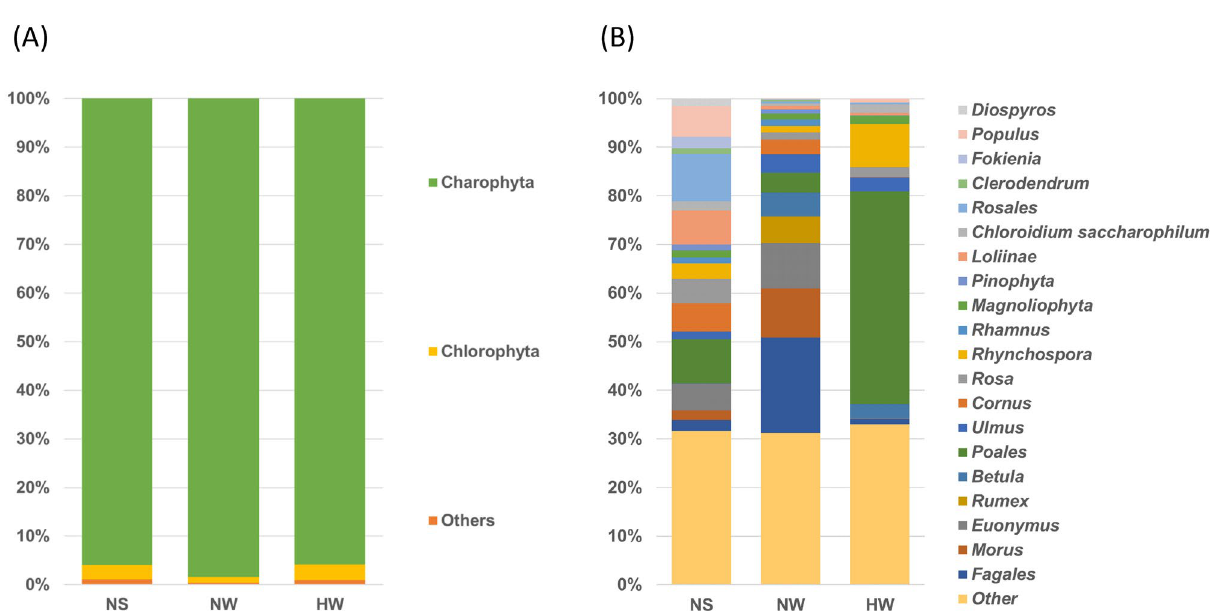
Figure 6. Average relative abundance of chloroplast taxa at the phylum ( A ) and genus ( B ) levels in the rumen chloroplast composition of each group. NW Nagano winter, NS Nagano spring, HW Hokkaido winter. The plant taxa were obtained from 18S rRNA amplicon-seq